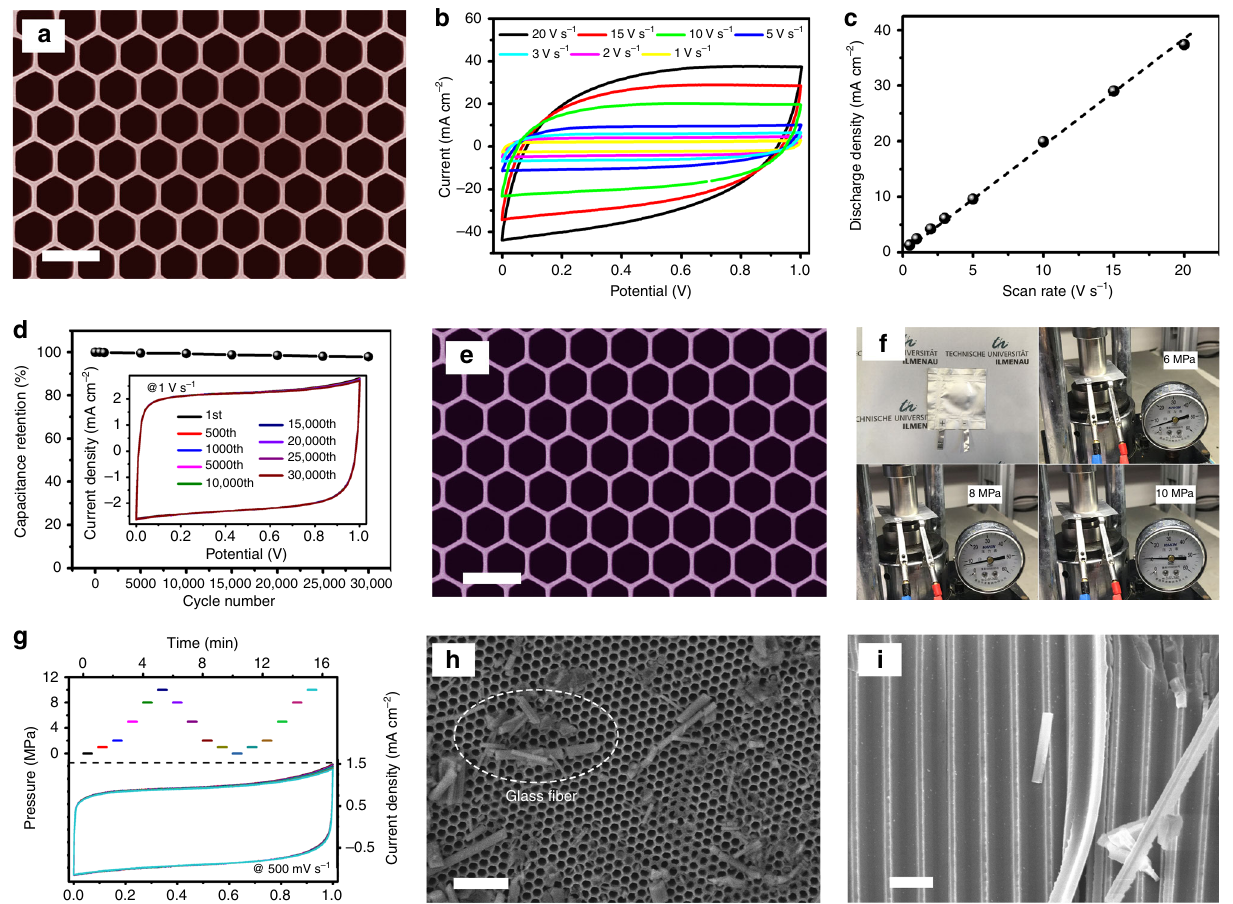
Fig. 2 Characterizations of HAN@SnO 2 as nanostructured current collectors. a Top-view SEM image of HAN@SnO 2 . b CV curves of HAN@SnO 2 // HAN@SnO 2 device at different scan rates. c The discharge current as function of the scan rates based on the CV curves of HAN@SnO 2 //HAN@SnO 2 device at different scan rates. d Cycling stability of HAN@SnO 2 //HAN@SnO 2 device tested at a scan rate of 1 V s − 1 . e Top-view SEM image of HAN@SnO 2 electrode after 30,000 CV cycles. f Photographs of HAN@SnO 2 //HAN@SnO 2 device tested under different mechanical extrusion pressure. g CV pro fi les of HAN@SnO 2 //HAN@SnO 2 device measured at a scan rate of 500 mV s − 1 under different mechanical extrusion pressure. h Top-view, and i cross- sectional SEM image of HAN@SnO 2 electrode after CV test under a mechanical extrusion pressure of 10 MPa, respectively. Scale bar: 500 nm ( a , e ); 2 μ m ( h ); 500 nm ( i